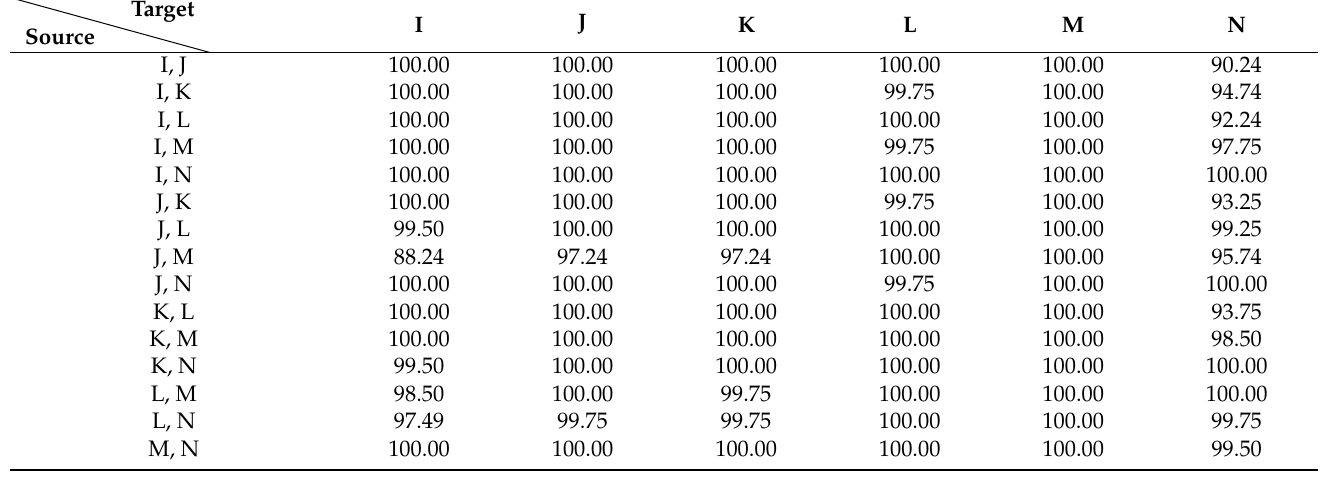
Table 8. Performance of ungeneralized model DCNG on MFPT dataset.